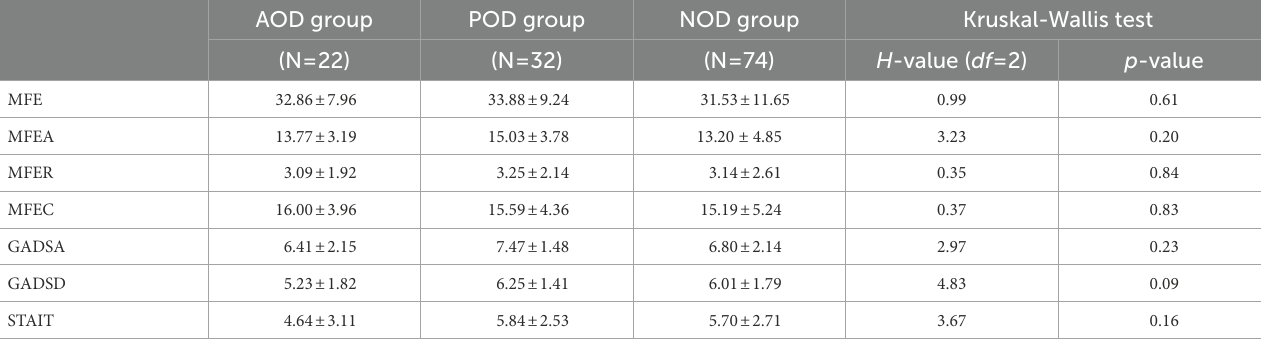
TABLE 3 Mean ± standard deviation of the study variables and group comparisons in the full sample.